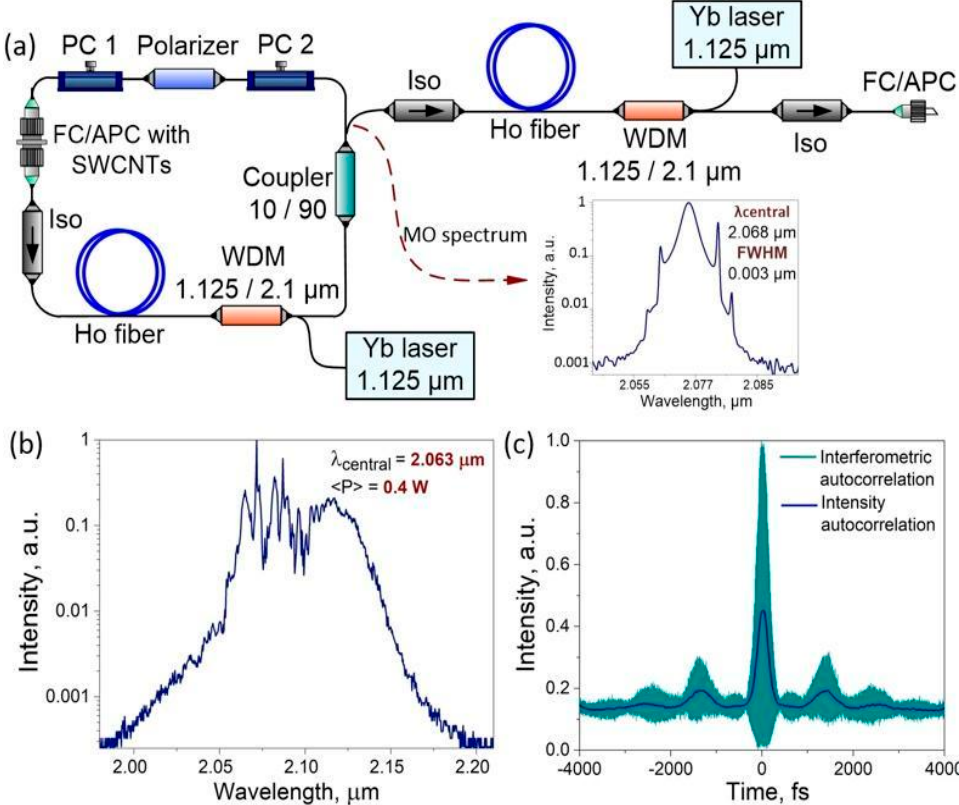
Figure 1. ( a ) Experimental setup of the all-fiber Holmium MOPA system operating in the ultrashort pulsed mode: WDM—wavelength division multiplexer, Iso—isolator, SWCNTs—single-walled carbon nanotubes, PC 1,2—polarization controllers; the output spectrum of Ho-doped fiber laser is presented on the inset (MO spectrum); ( b ) Lasing spectrum and ( c ) autocorrelation trace of the output pulse corresponding to the average output power of 0.4 W.